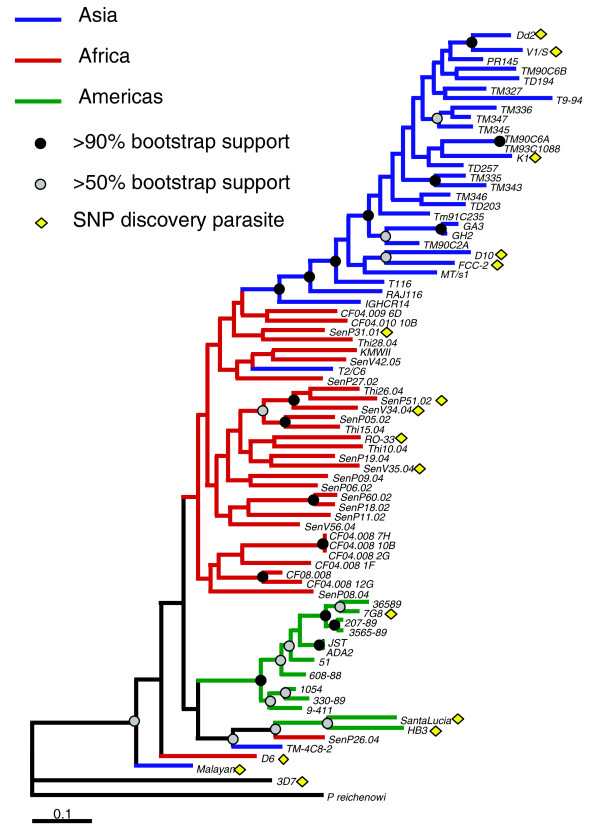
Maximum likelihood phylogeny of global samples. Blue, red, and green branches represent parasites from Asia, Africa, and the Americas, respectively. Parasites that were sequenced and thus were used for the discovery of SNPs are indicated by yellow diamonds. Nodes exhibiting bootstrap support levels of at least 50% or 90% are indicated by gray dots and black dots, respectively.